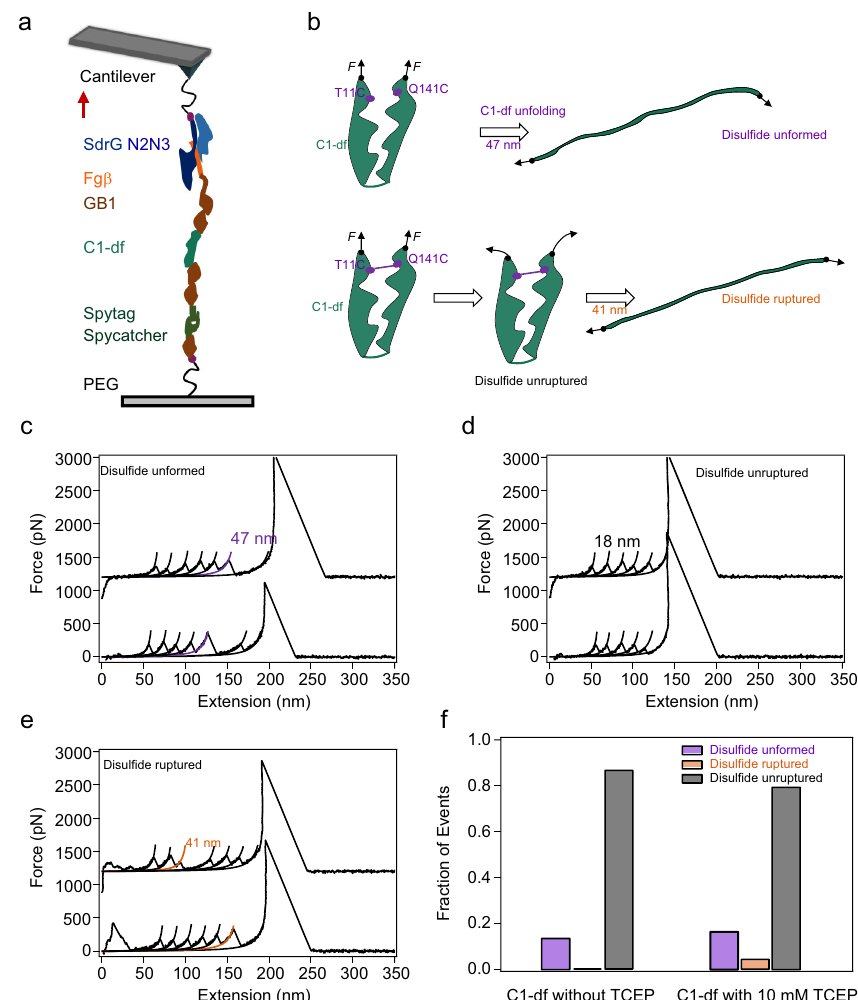
Fig. 5 Mechanical unfolding of C1-df. a Schematic of the AFM-based single-molecule force spectroscopy experiments. Polyprotein Fg β -(GB1) 2 -C1-df- (GB1) 2 -Spytag was linked to the cys-GB1-Spycatcher modi fi ed substrate covalently through the Spycatcher/Spytag chemistry and picked up by the SdrG- cys modi fi ed cantilever through the Fg β /SdrG interaction. Thus, the force – extension curves should contain fi ve GB1 fi ngerprints. b Three possible unfolding/hydrolysis pathways of C1-df under load and the corresponding contour length change. c Representative force – extension curves of the “ Disul fi de unformed ” group. Two populations of unfolding events as showed, fi ve peaks in black related to GB1 unfolding and the purple one with Δ L c of 47 nm corresponds to the unfolding of C1-df. d Representative force – extension curves of the “ Disul fi de unruptured ” group. The traces show only fi ve GB1 unfolding events without the signature of C1-df unfolding or disul fi de bond rupture. e Representative force – extension curves of the “ Disul fi de ruptured ” group. Except for the fi ve GB1 unfolding events, there is an additional peak with Δ L c of 41 nm (colored in orange) corresponding to the rupture of the disul fi de bond. f 2D bar shows the relative populations of the three kinds of events without (left, n = 193) or with (right, n = 389) 10 mM TCEP. This experiment was repeated 4 times independently with similar results. Source data are provided as a Source Data fi